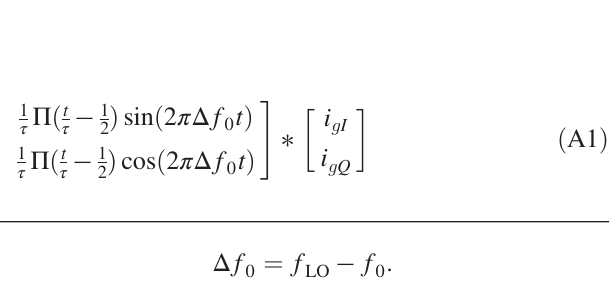
FIG. 25. Impulse response to generator current. Diagonal term h